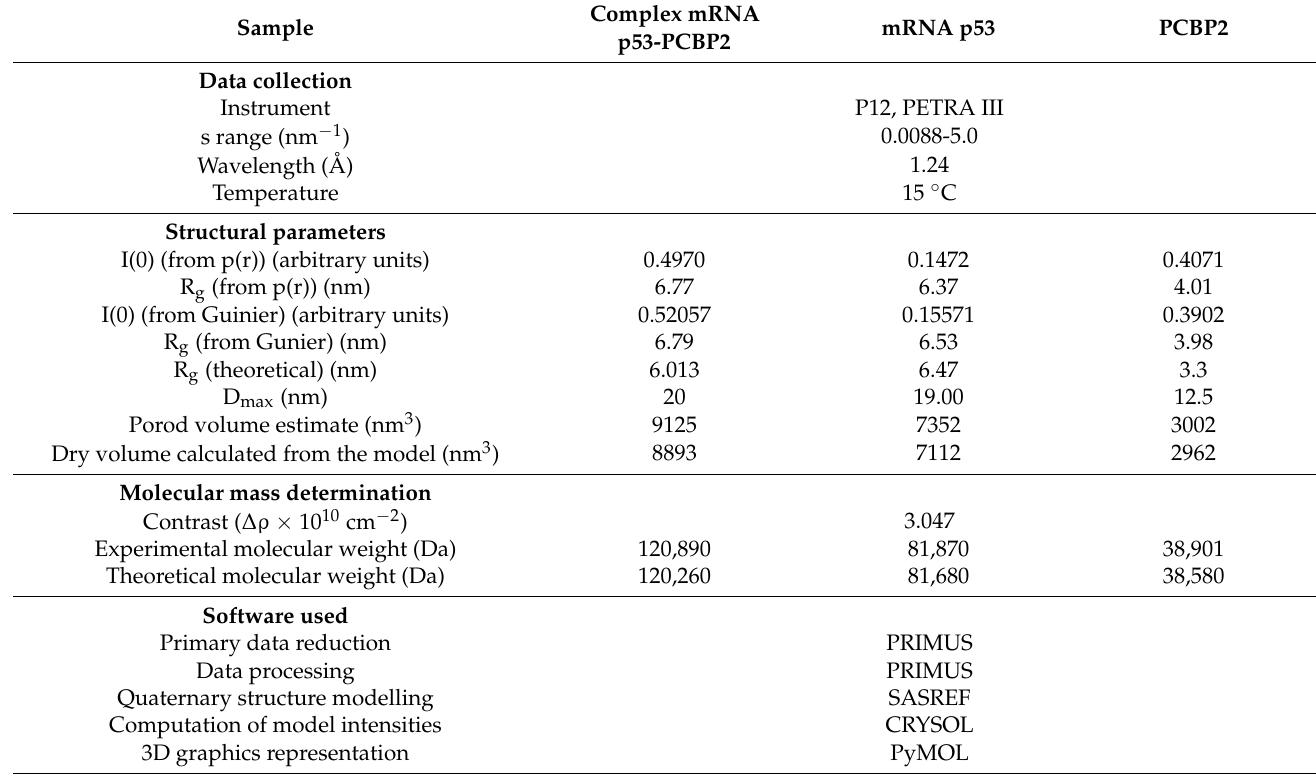
Figure 6. SAXS data for P1- Δ 40p53 RNA—PCBP2 complex. ( a ) Quaternary structure of the complex obtained by SASREF (grey—RNA model, green—protein model). ( b ) Experimental SAXS curve used to model the quaternary structure of the P1- Δ 40p53 RNA—PCBP2 complex (black line) in the region 0.01–2 nm − 1 , the red line shows the theoretical fit to the experimental data ( χ 2 = 1.34). Guinier plot shows that the analysed system is monodisperse (insert). Table 2. SAXS data collection and structural parameters derived for complex P1- ∆ 40p53—PCBP2, P1- ∆ 40p53 RNA and